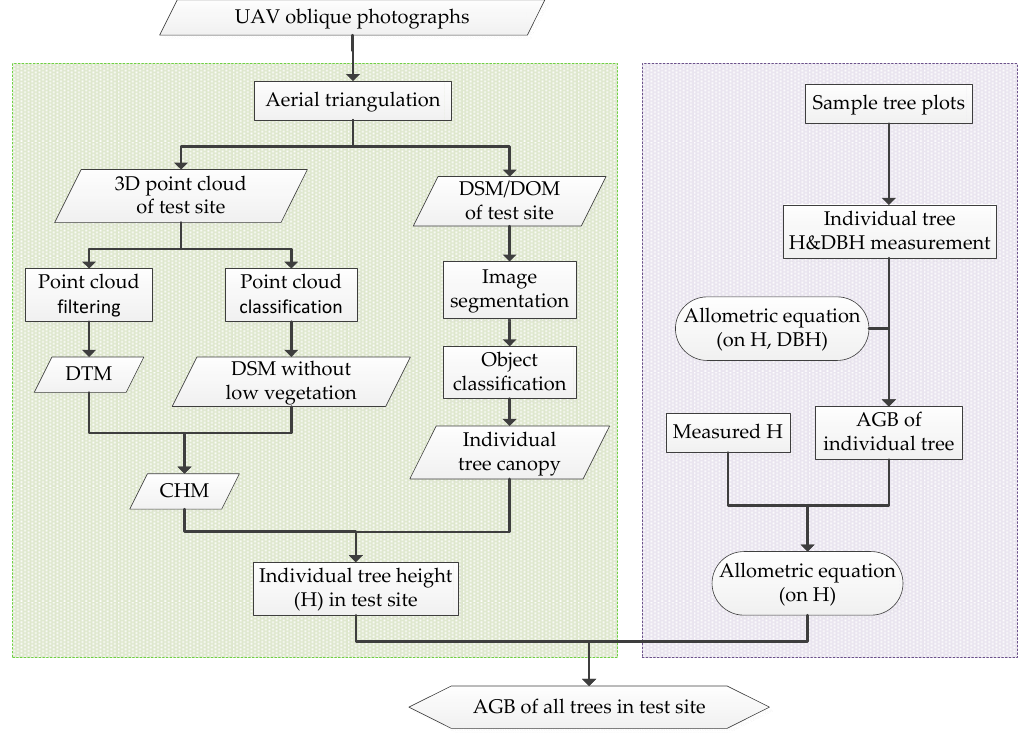
Figure 4. Flowchart of the tree Aboveground Biomass (AGB) estimation of a sparse subalpine